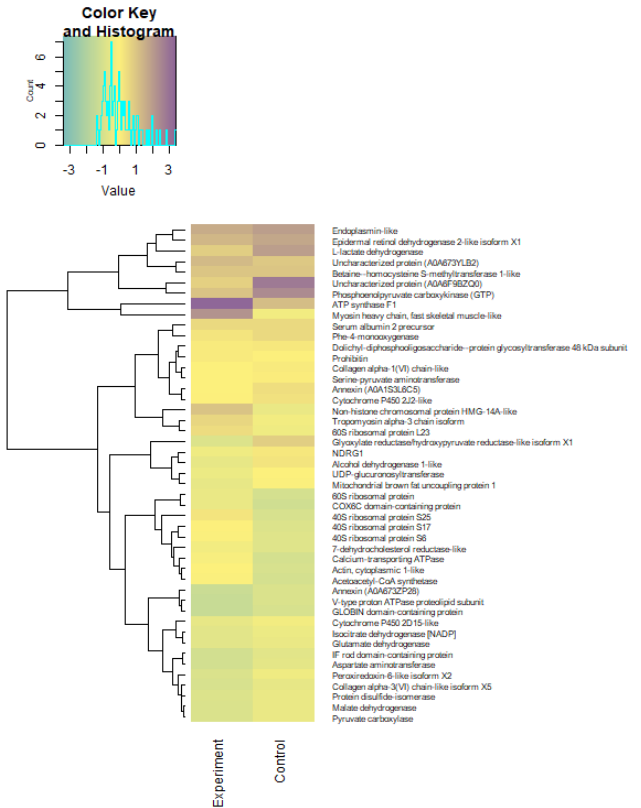
Figure 15. Heatmap LFQ Z- scores of normalized data of a “low concentration” proteome (group 3) in underyearlings of Atlantic salmon ( Salmo salar L.) for control and experimental groups.